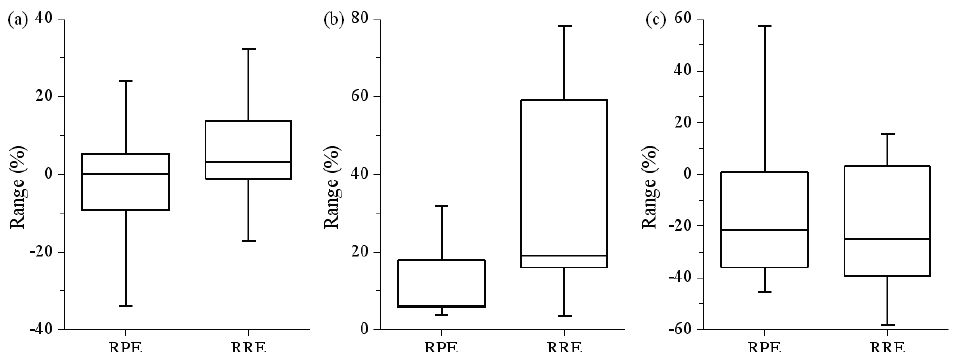
Fig. 2 Boxplots of RPE and RRE accuracy statistics for: (a) the period 1960–2000 using two split parameter value groups, (b) the period 1990–2000 using the parameter values for the period 1960–1989, and (c) the period 1960–1989 using the parameter values for the period 1990–2000.